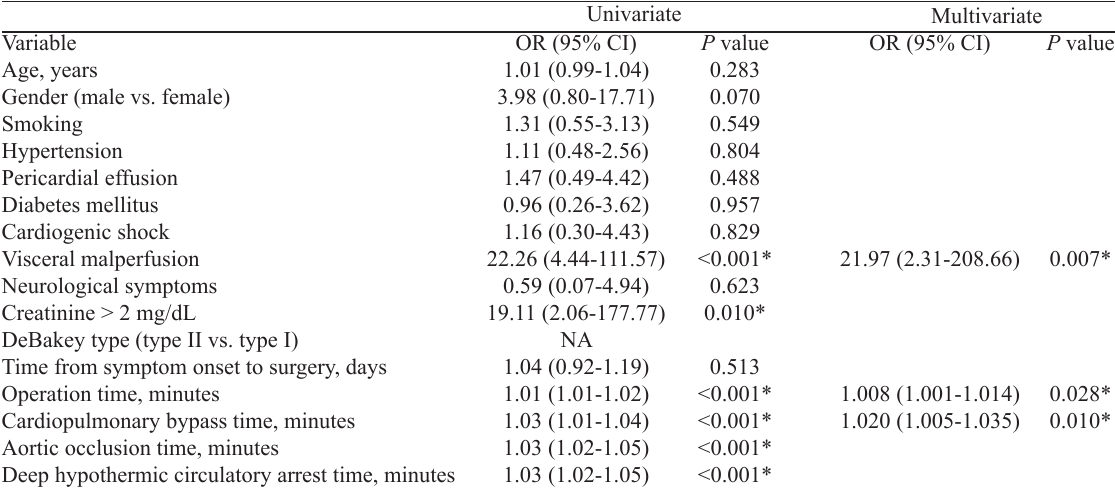
Table 3. Associations between demographic and clinical variables and postoperative complications